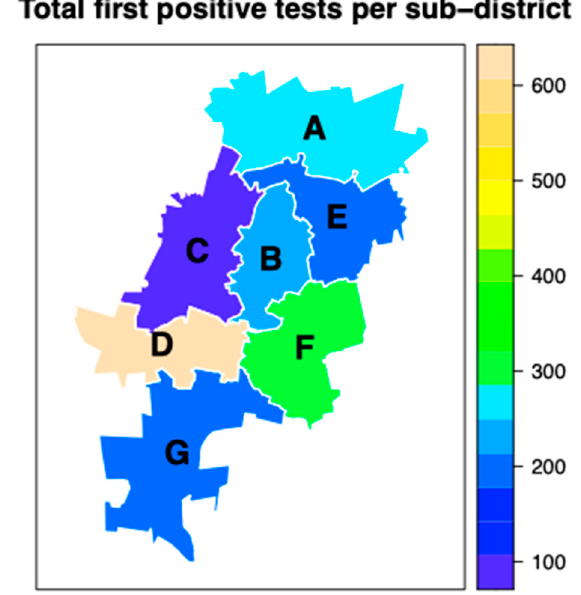
Figure 3. Total first HIV PCR positive tests per subdistrict in the Johannesburg Health District, October 2018–September 2021.